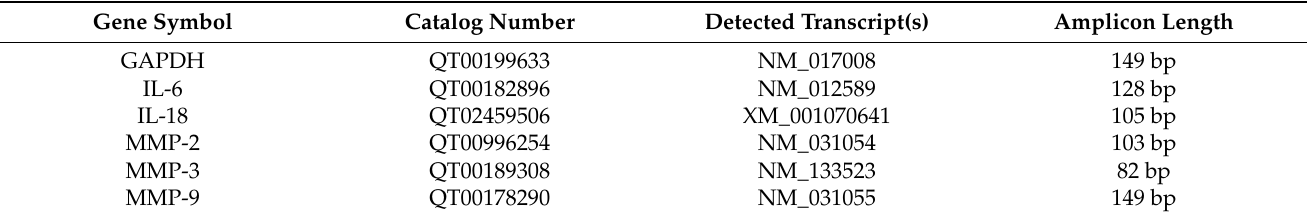
Table 2. Primer information for gene expression in qPCR experiment.